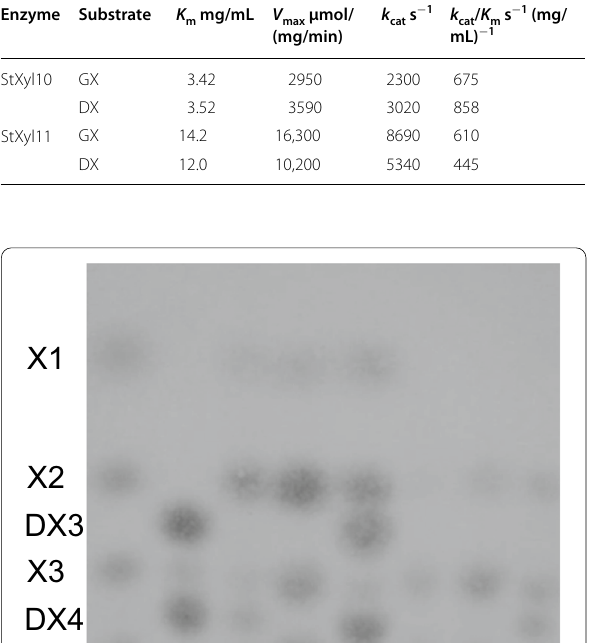
Table 1 Kinetic parameters of StXyl10 and StXyl11 Enzyme Substrate K m mg/mL V max μmol/ (mg/min)